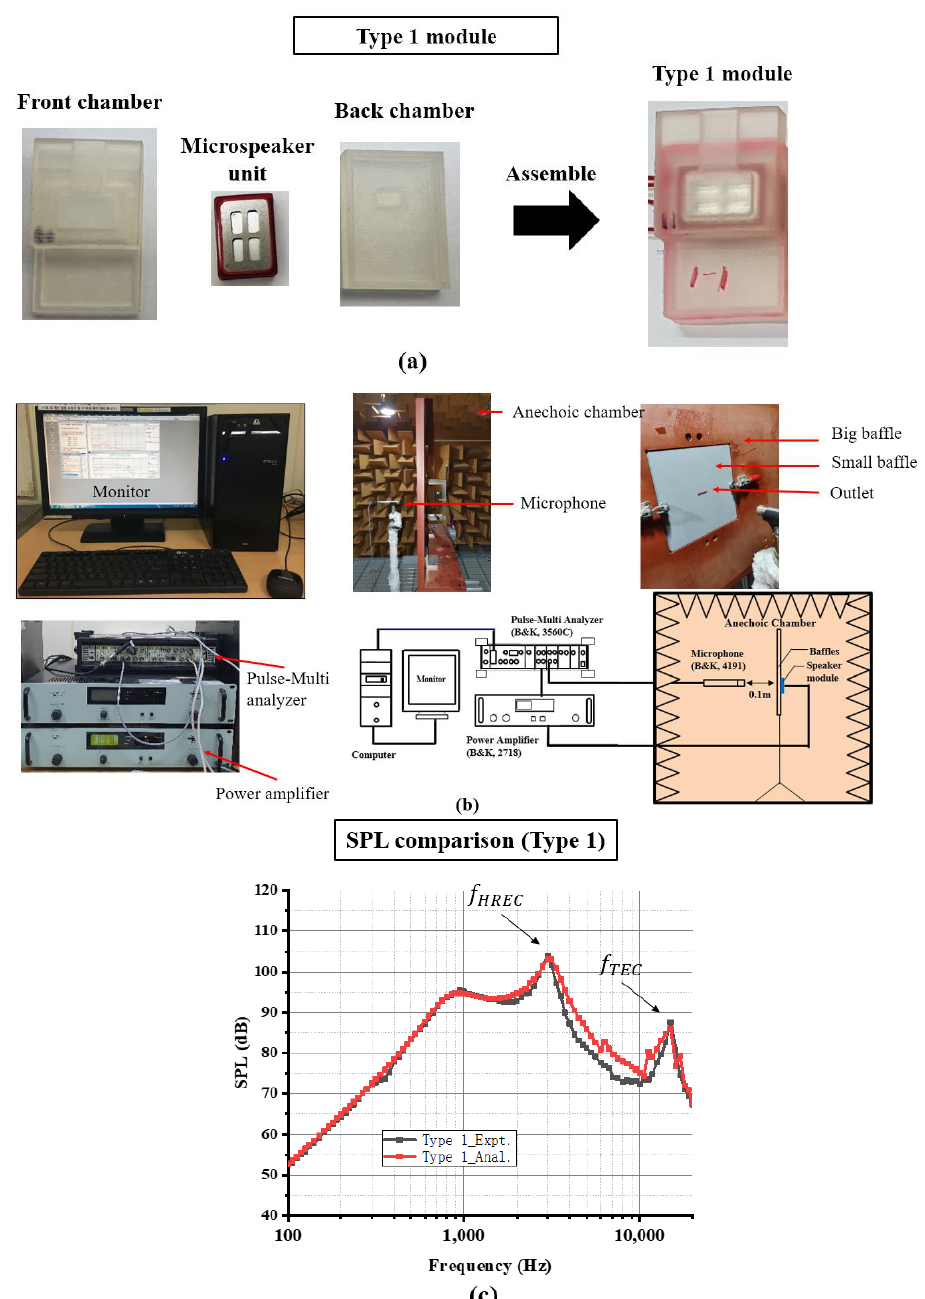
Figure 8. Experimental setup and results: ( a ) microspeaker module samples, ( b ) the schematic of B&K setup, and ( c ) SPL comparison (Type 1).